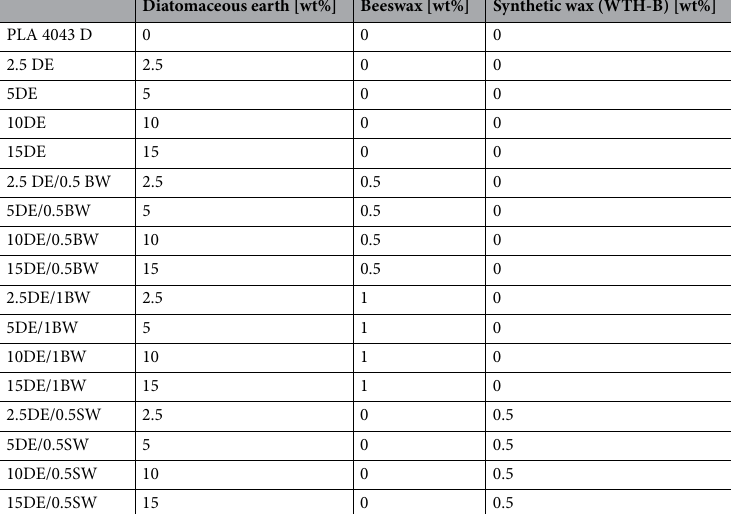
Table 3. Composition of the composites